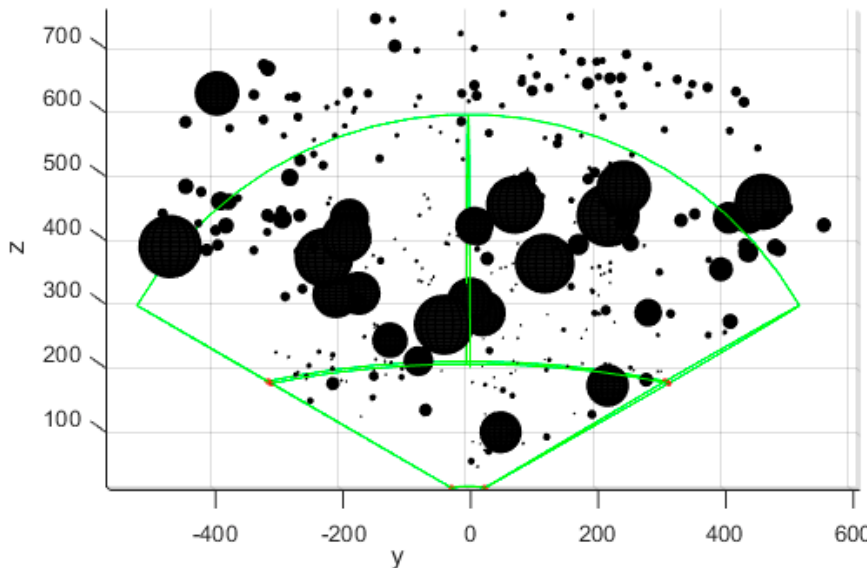
Figure 12. Up to 80 cm: side view. Z and y axis are in mm.